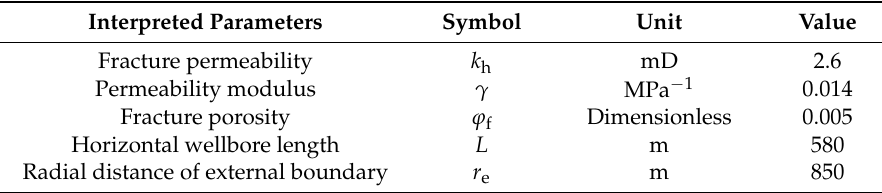
Table 4. Main interpreted parameters for field